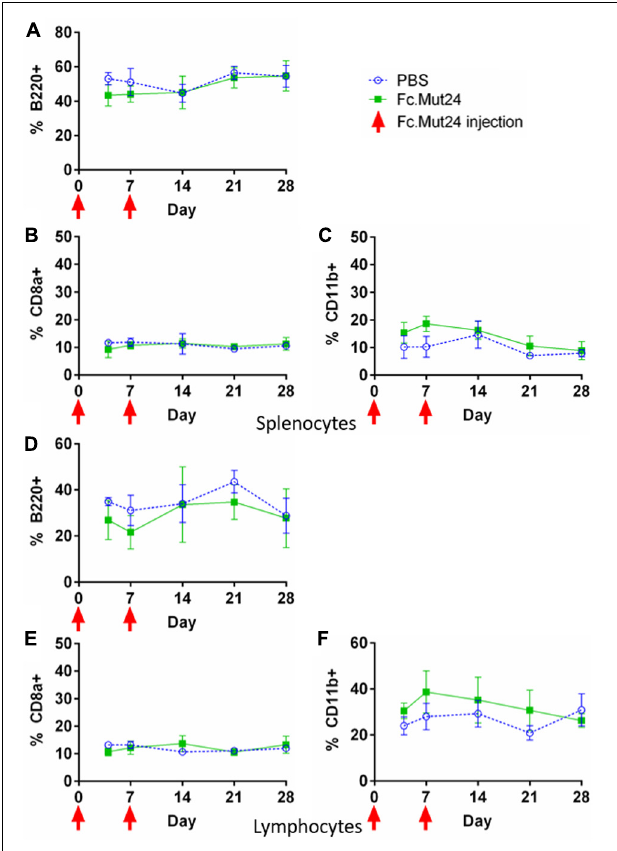
FIGURE 5 | Characterization of B220 + , CD8a + , and CD11b + cells in the spleen and the peripheral blood of Fc.Mut24-treated and FVIII plasmid gene therapy-treated mice. The mice treated with Fc.Mut24 ( n = 3) or PBS ( n = 3) in conjunction with FVIII plasmid gene therapy were sacrificed at separate time points, and their spleens (A–C) and peripheral blood (D–F) were collected for analysis by flow cytometry. B220 was used as a marker for B cells (A,D) , CD8a as a marker for cytotoxic T cells (B,E) , and CD11b as a marker for myeloid cells (C,F) . All percentages are calculated from total lymphocytes from peripheral blood or total splenocytes from spleens. The experiments were repeated at least twice without significant variation. The data are presented as means with standard deviation. p > 0.05 at all time points. The p -values were calculated at individual time points by non-parametric Mann–Whitney U